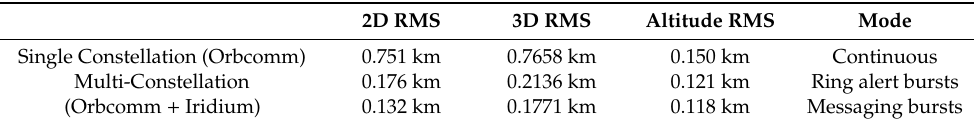
Table 2. Comparison between Root Mean Square (RMS) error of each